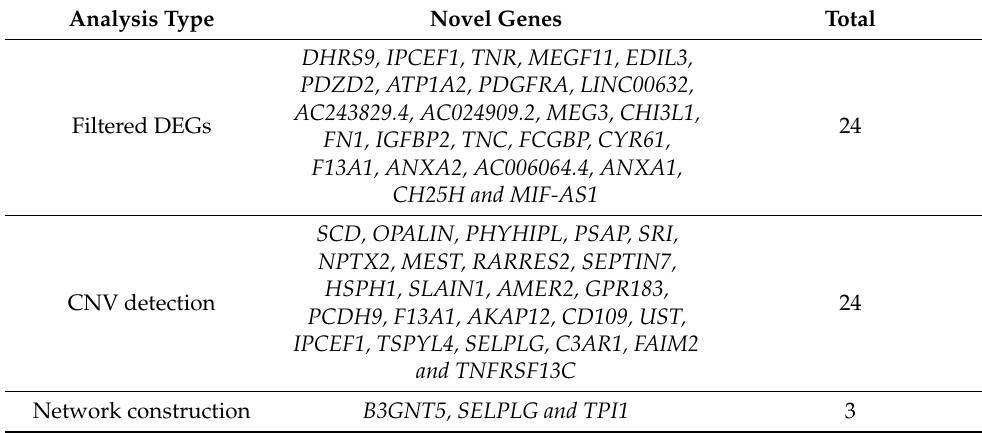
Table 2. Novel genes identified from our